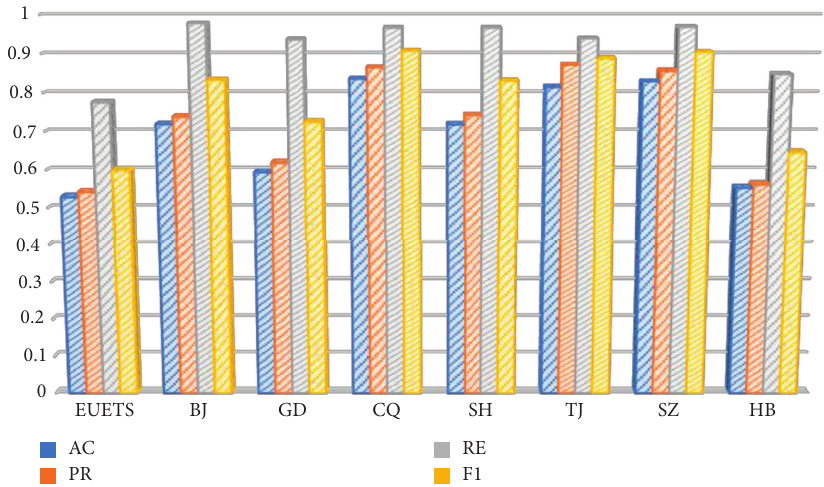
Figure 6: Comparison of price trend prediction effect between the EU and seven pilot carbon markets in